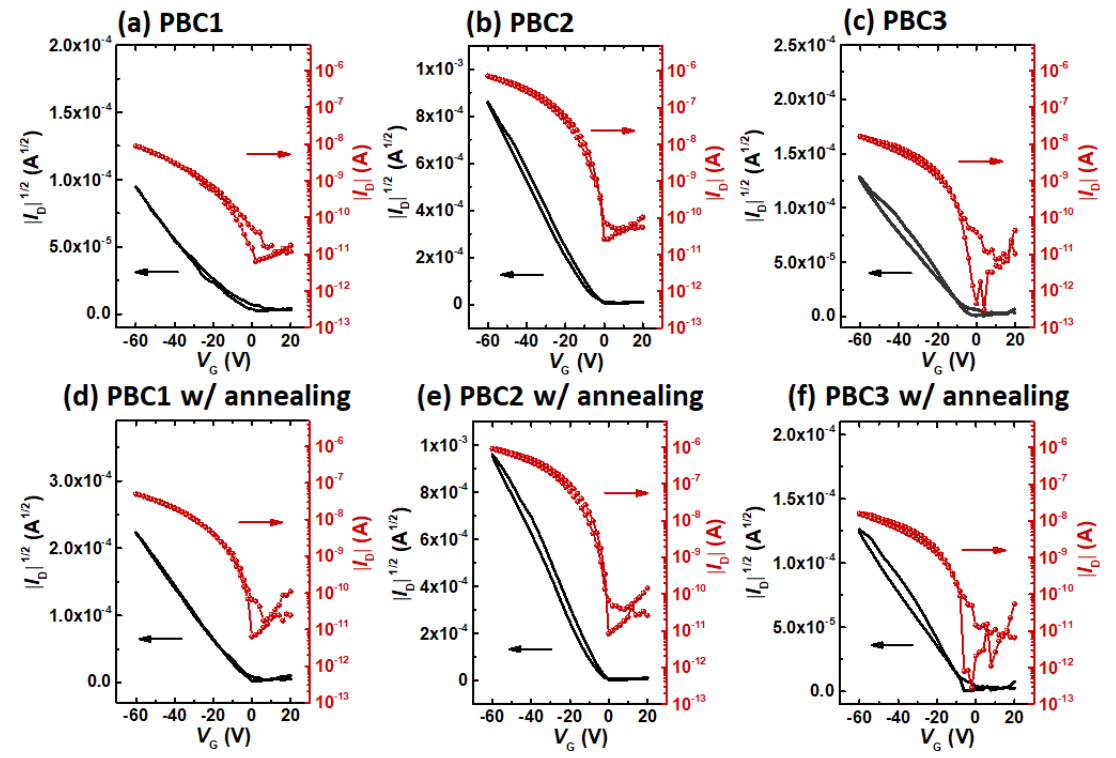
Figure 2. Charge transfer curves of ( a , d ) PBC1, ( b , e ) PBC2, and ( c , f ) PBC3 devices in as-casted films ( a – c ) and after thermal annealing (( d ): 200 °C, ( e ): 100 °C, ( f ): 100 °C).